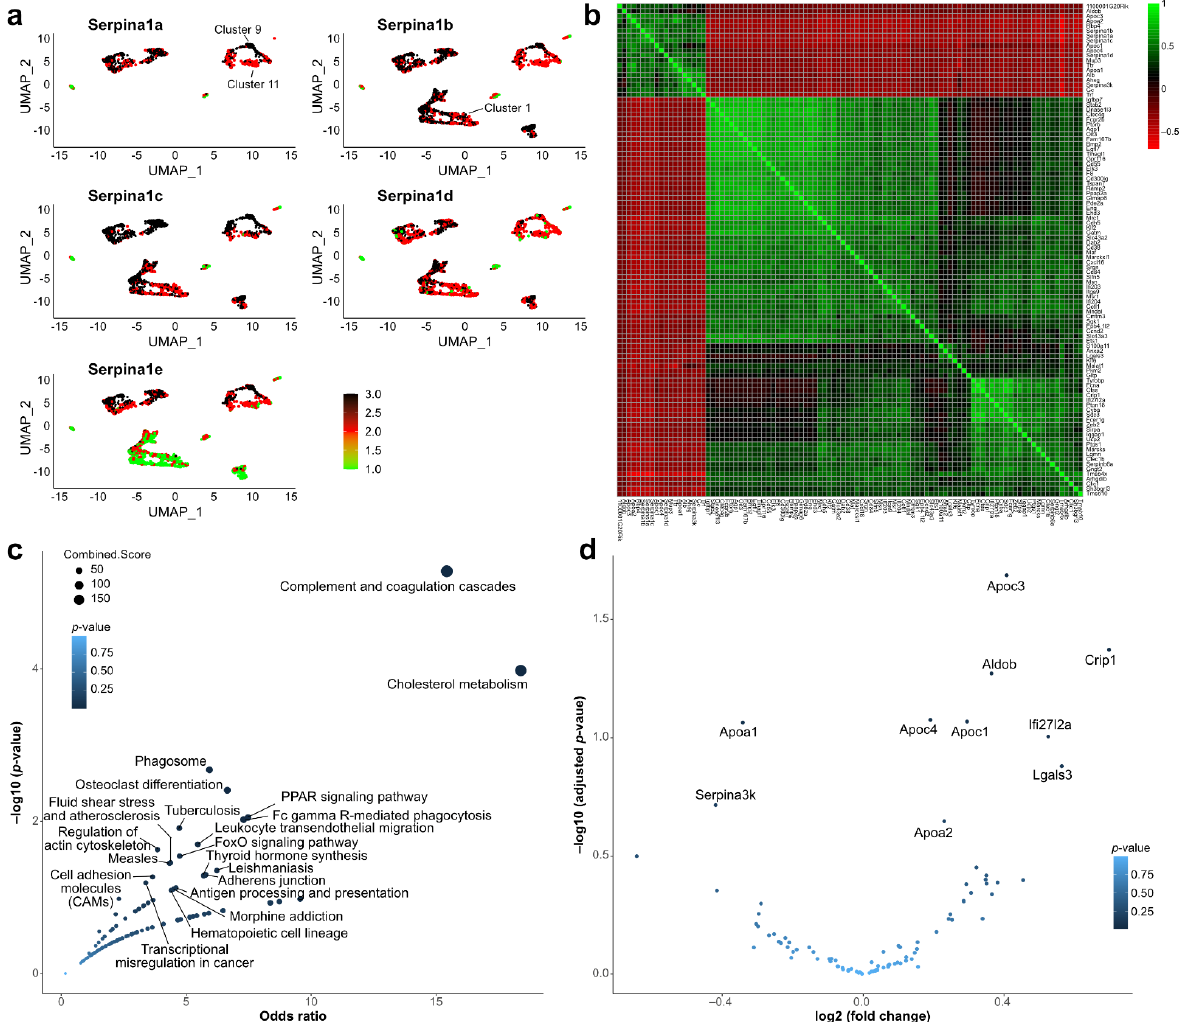
Figure 3. scSEQ data analysis of Serpina1 gene expression. ( a ): Global expression of Serpina1 isoforms: Serpina1 was broadly expressed in the wild-type mice, with two among thirteen clusters that showed a lower expression. ( b ): Correlation matrix of Serpina1 : Top 100 genes with Serpina1 highly correlated are shown in this plot with highly correlated genes in green and anti-correlated genes in red. ( c ): Pathway enrichment of correlated genes. ( d ): Expression changes in the KO dataset of the correlated genes (n = 100). The ten most highly significant DEGs are annotated.